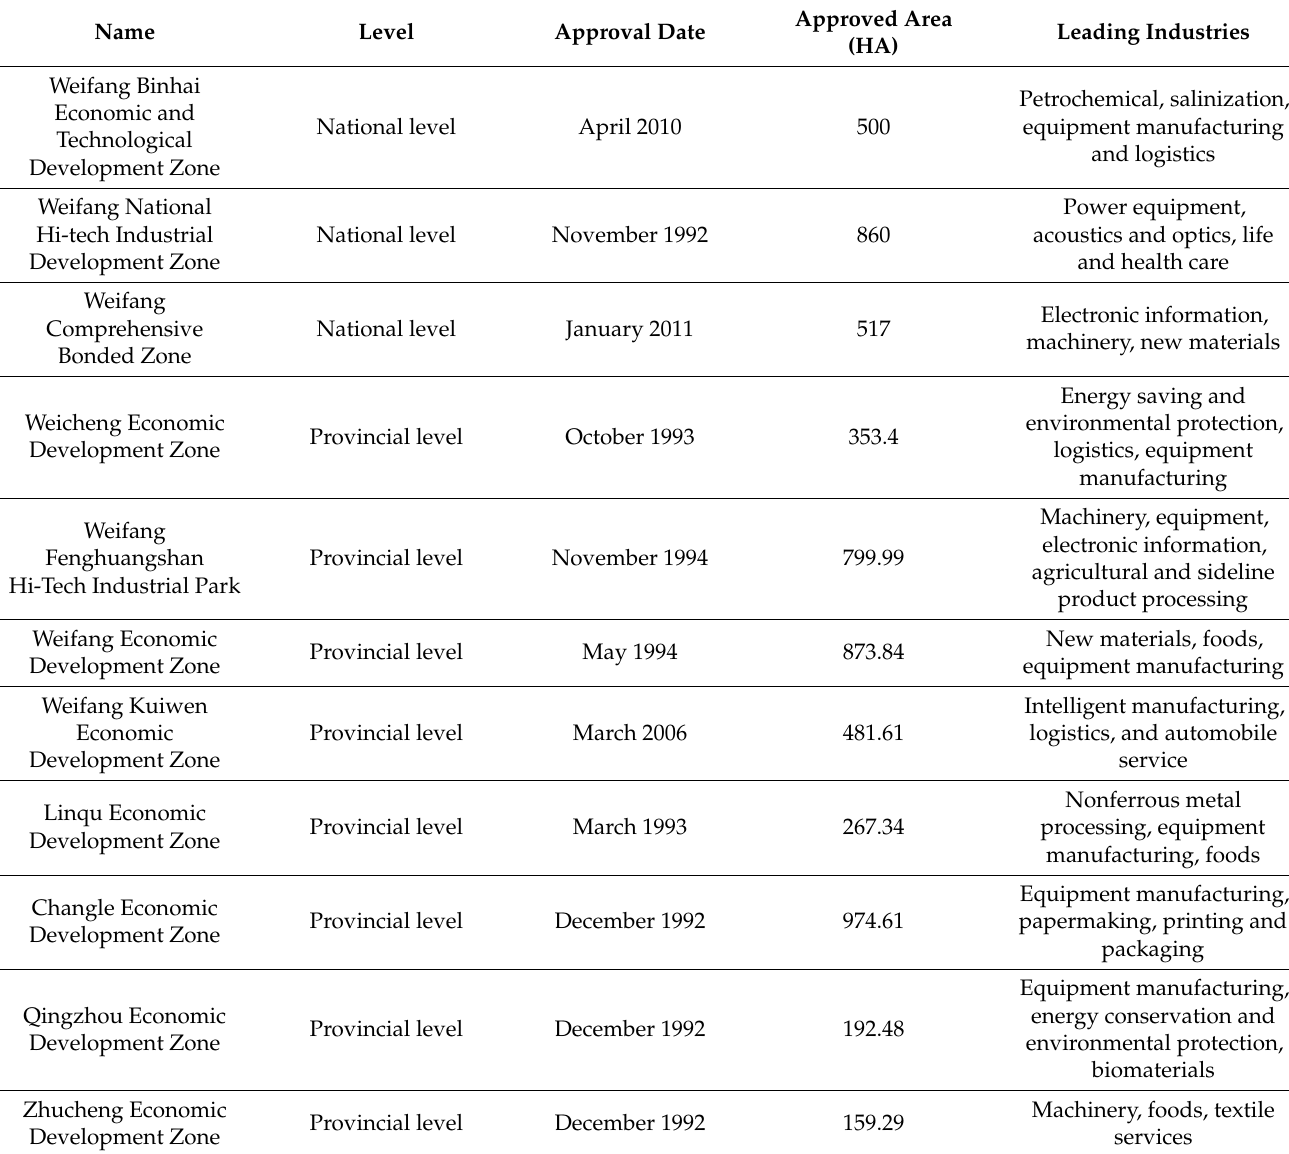
Table 1. Basic information on development zones in